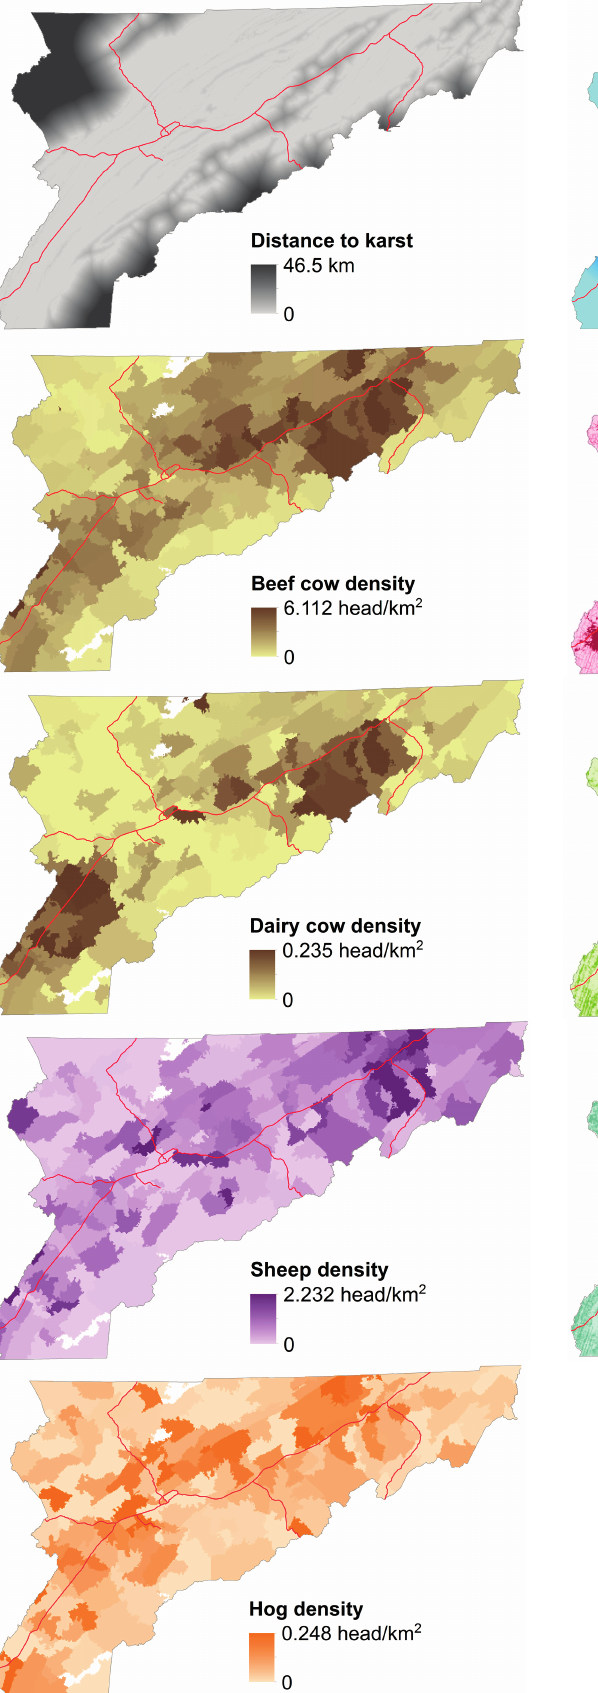
Figure 2. Environmental risk factors used as covariates in the spatial logistic regression